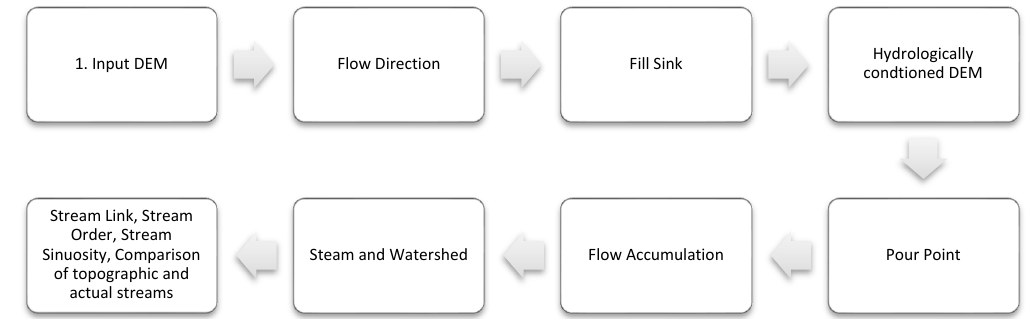
Figure 2. Procedure for hydrological conditioning, watershed delineation and derivation of stream network characteristics in ArcMap 10.2. The stream network, followed by stream links, were built by choosing the USGS’s 4.5 km 2 threshold that generated a seventh order stream (Strahler’s method) for the Grand River. A radius of 50 metres was indicated to ensure the pour point was snapped onto the cell with the highest flow accumulation within the specified